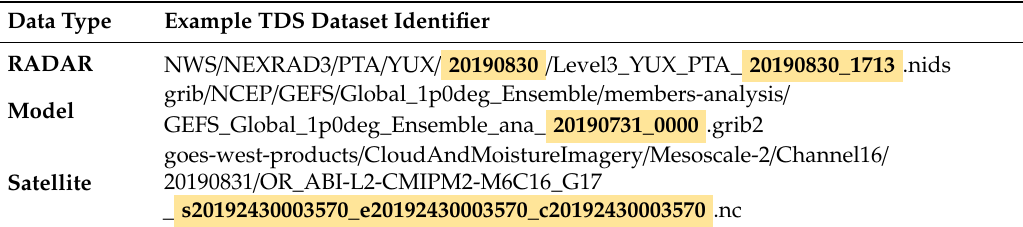
Table 3. TDS dataset identifiers for three types of data. The portion of the identifiers that contain temporal information is highlighted.